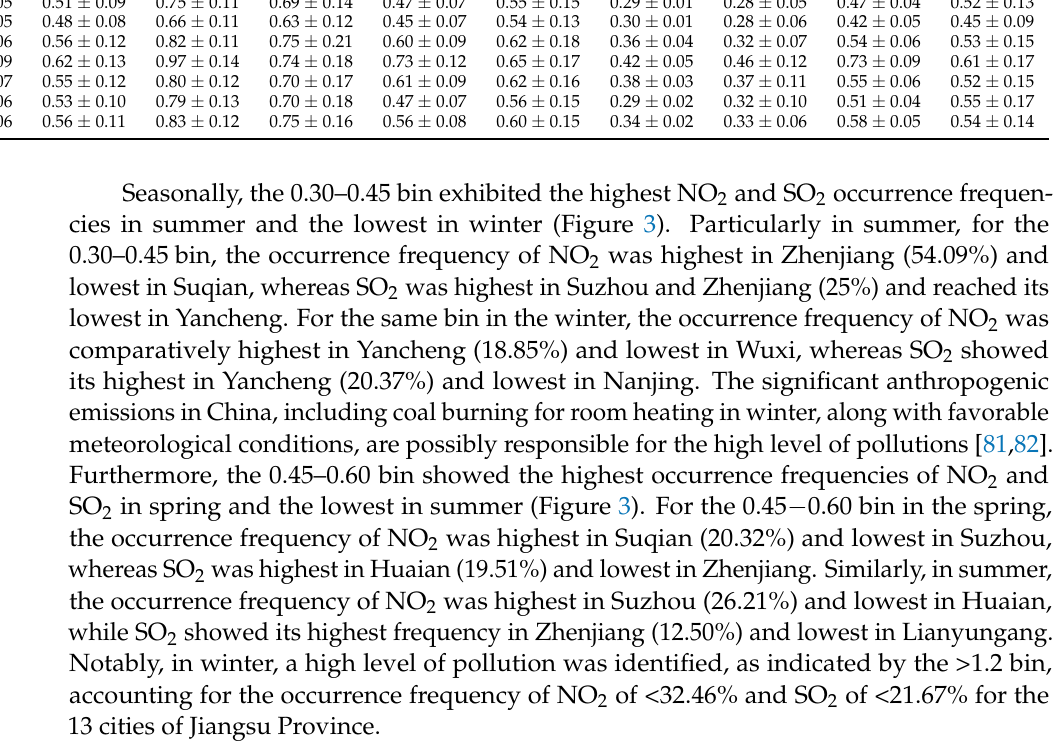
Figure 3. Annual and seasonal frequency distributions of OMI-retrieved total column NO 2 (DU) and SO 2 (DU) in 13 cities of Jiangsu Province from 2005 to 2020.